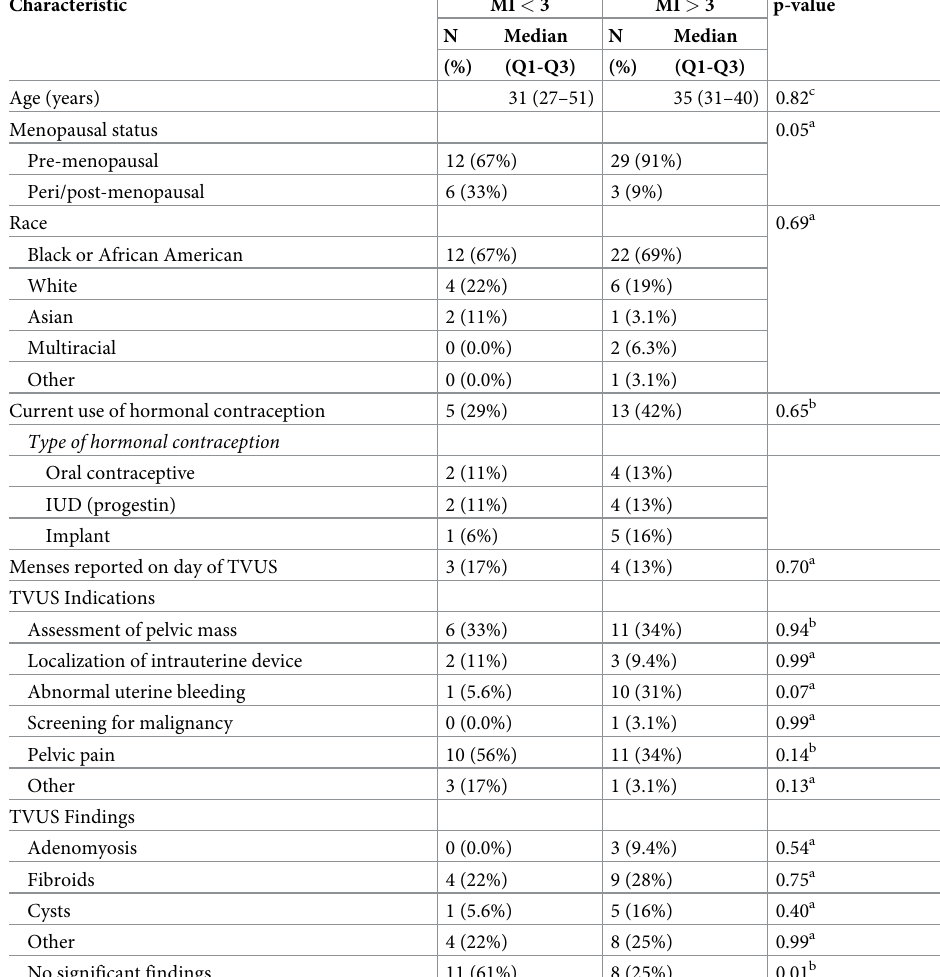
Table 1. Demographic and clinical description of study participants with a pre-TVUS epithelial cell maturity index (MI) less than or more than 3. Characteristic